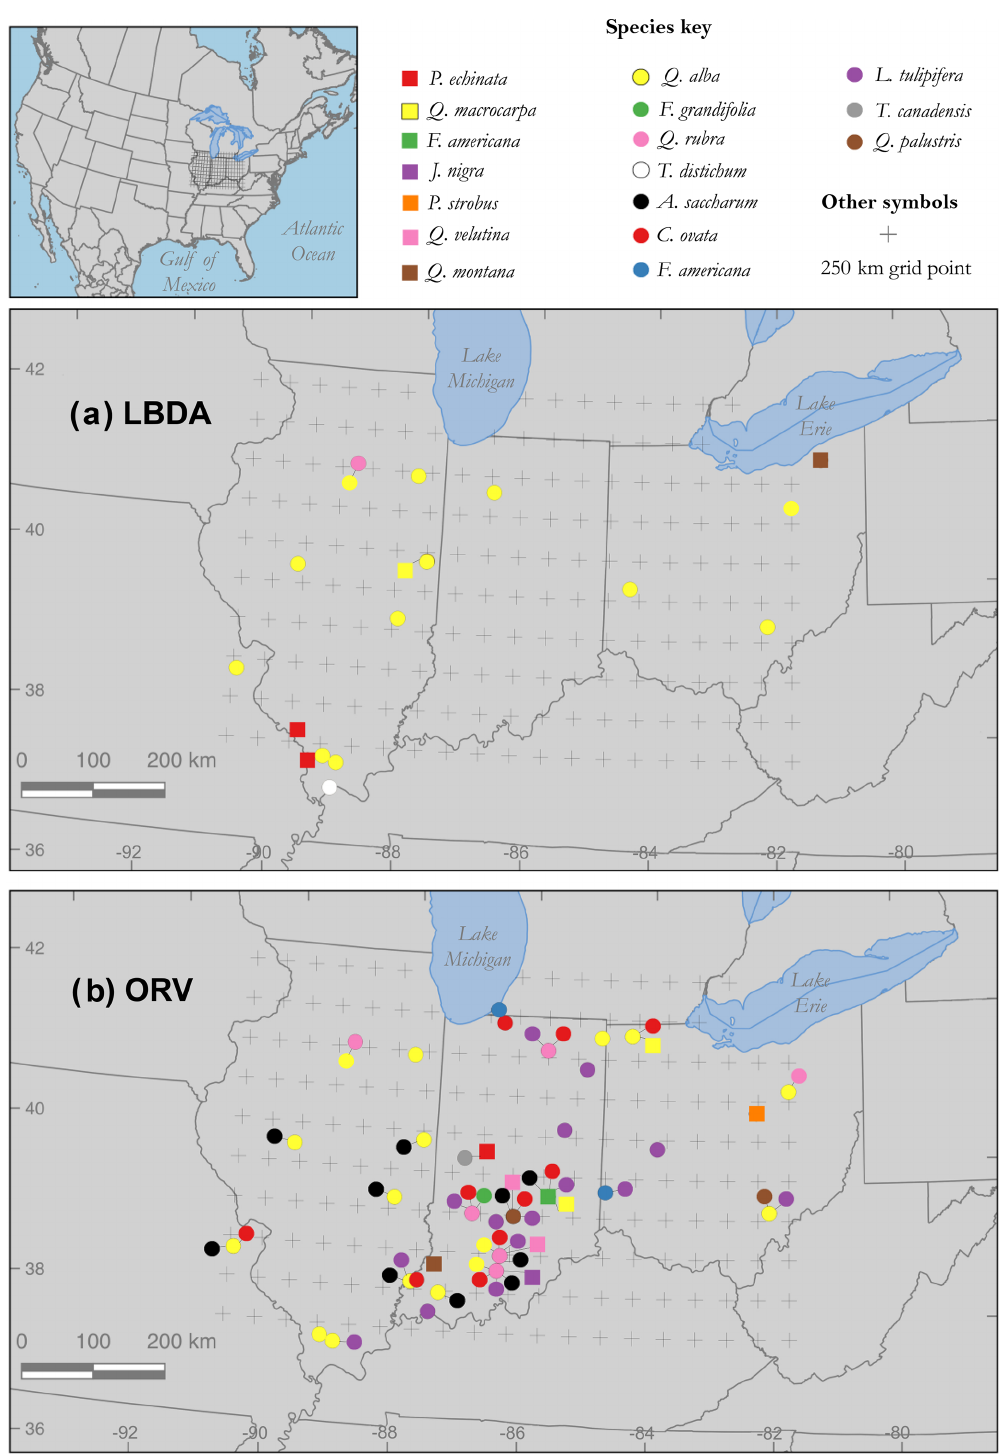
Figure 1. Map of 0 . 5 ◦ × 0 . 5 ◦ PMDI grid points ( n = 181) across the Ohio River valley (ORV) region, Midwest US, defined as 37.75– 42.25 ◦ N, 90.75–82.25 ◦ W, plotted with tree-ring chronology sites included from the (a) ITRDB and (b) ORV networks. Sites with single- species and multiple-species data are denoted by symbol shape and color (see Table S1 in the Supplement). Note that most ITRDB sites consist of single-species data in the LBDA but multiple species are represented in the